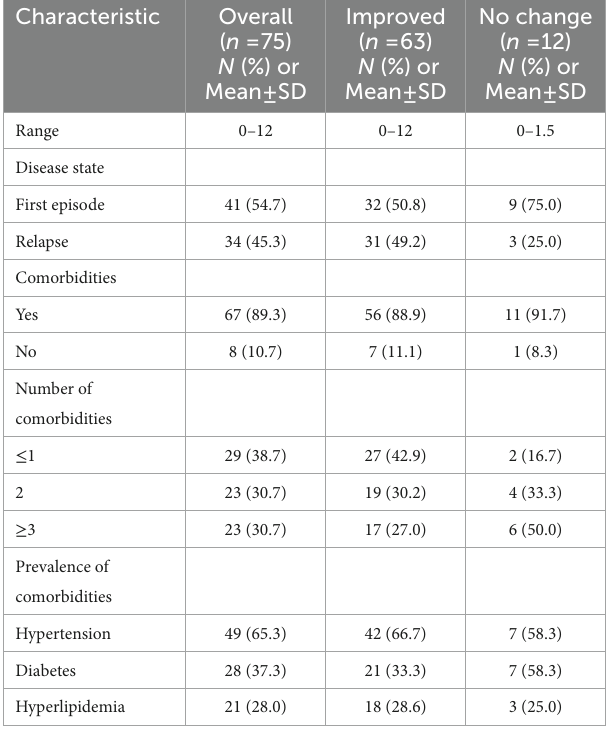
Table 2 describes the score distribution of the EQ-5D-5L HSU and SAQ at both time points. The mean EQ-5D-5L HSU scores at baseline and follow-up were 0.850 and 0.975, respectively, with an average change of 0.125 ( p < 0.001). For the SAQ, the mean scores were 56.414 and 72.077 at the two time points, respectively, with an average change score of 15.663 ( p <